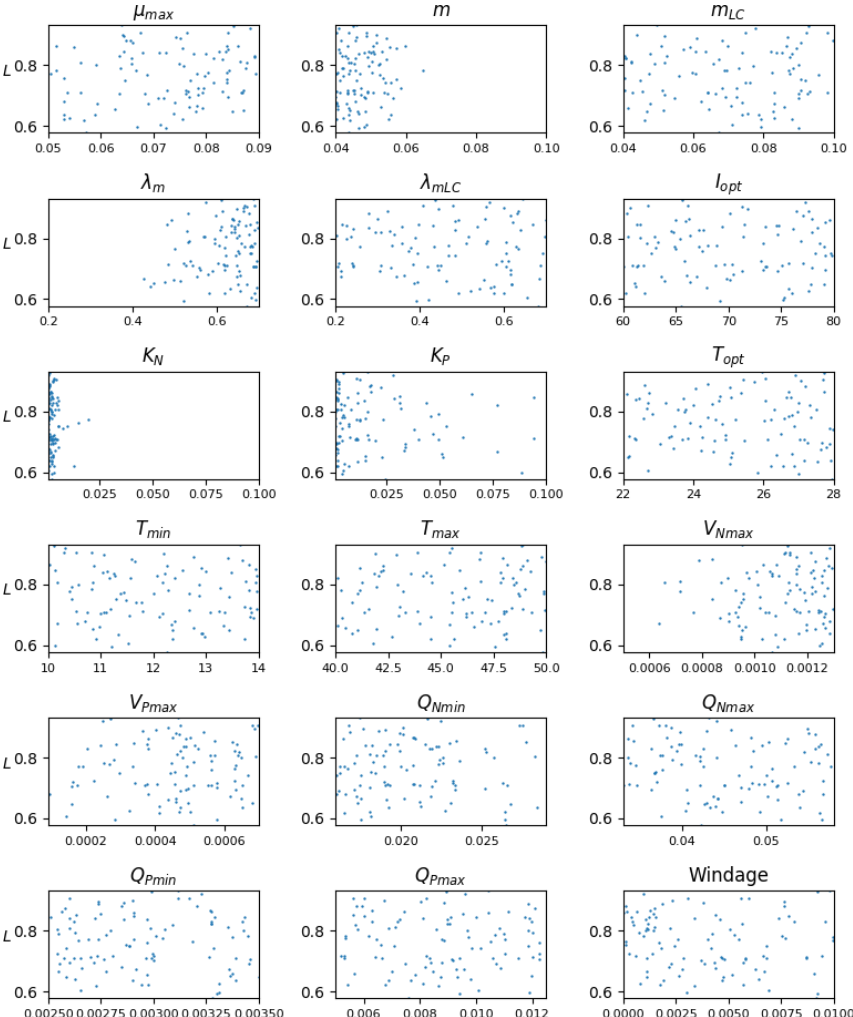
Figure 6. Likelihood ( L ) as a function of the different parameters that have been varied in the optimization experiment, shown here for the ensemble (cid:127) 100 that composes the ensemble averages in Figs. 4 and 5. Units are given in Table